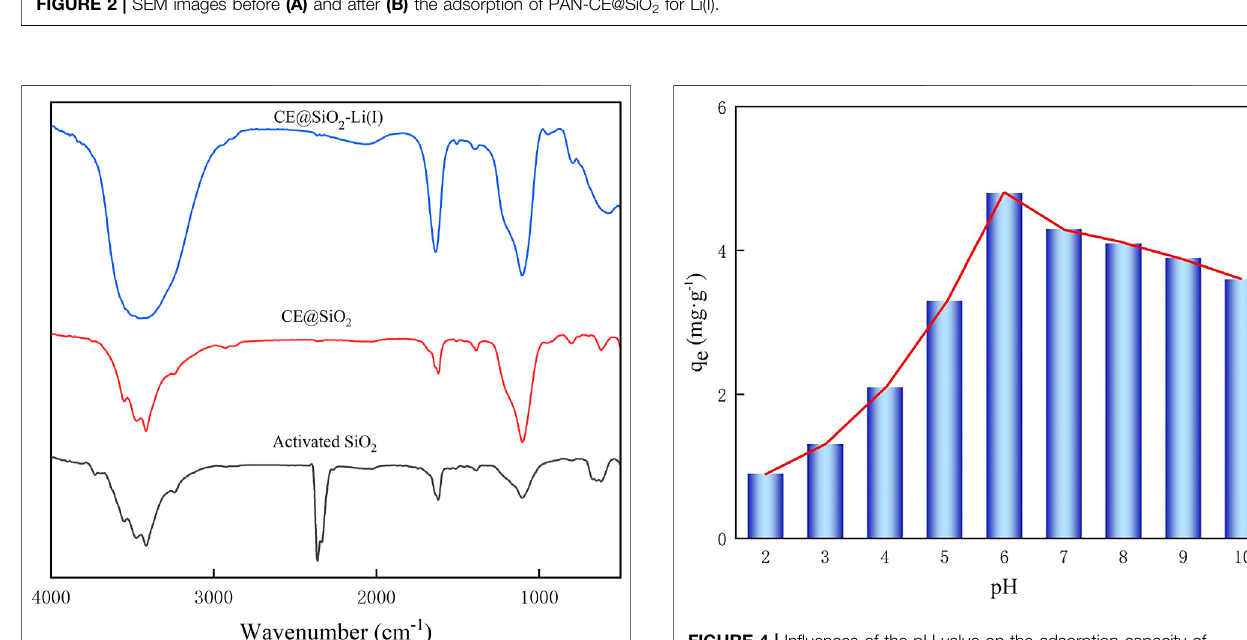
FIGURE 2 | SEM images before (A) and after (B) the adsorption of PAN-CE@SiO 2 for Li(I).